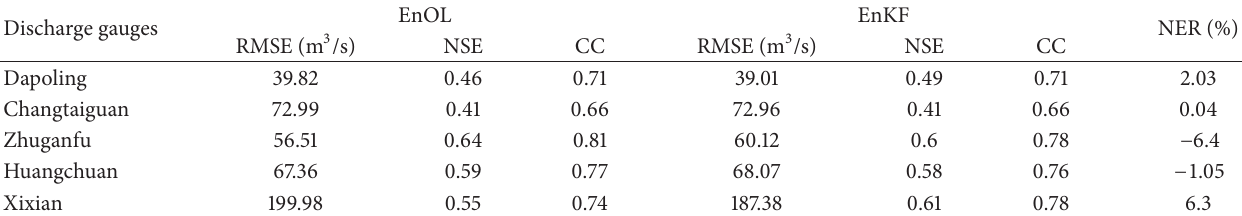
Table 5: The statistics of the estimated streamflow obtained by EnOL and EnKF at the five interior discharge gauges. Discharge gauges